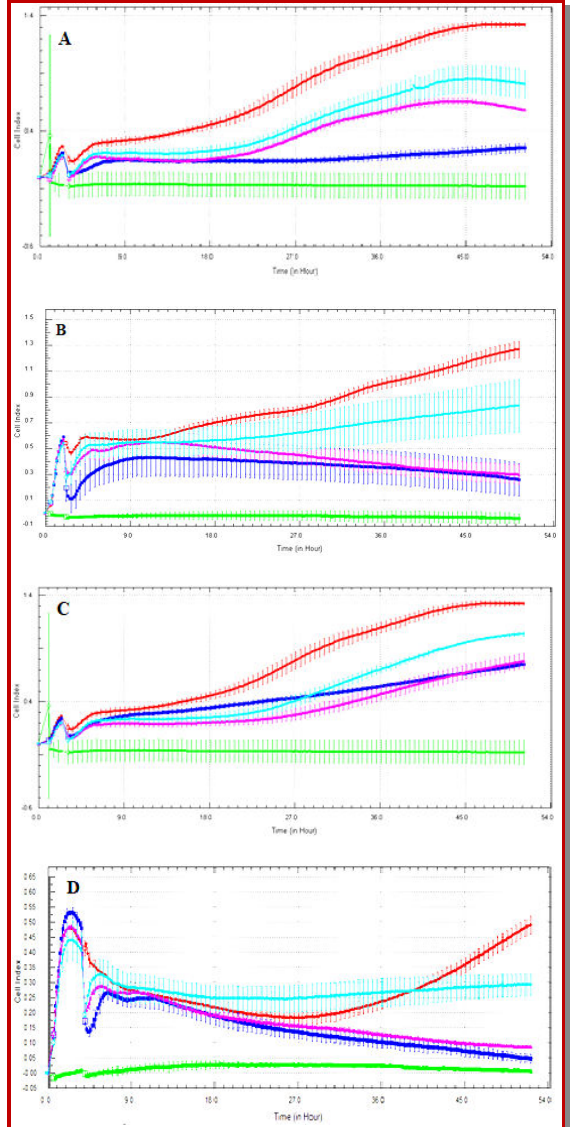
Figure 3: The anti-cancer activity of the n -butanol extract of P. coronopifolia against HeLa and C6 (2,5 x 10 4 cell/well) cells line at several extract concentrations ( ▬ 50 µg/mL, ▬ 100 µg/mL, ▬ 250 µg/mL, ▬ Control, ▬ Medium). Profileration assay of the n -butanol extract of P. coronopifolia (A) and the 5-fluorouracil as a positive control (B) against HeLa cells; Proliferation assay of the n -butanol extract of P. Coronopifolia (C) and the 5-fluorouracil as a positive control (D) against C6